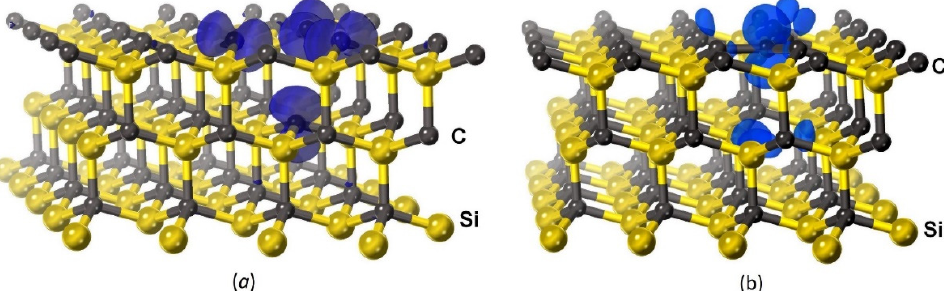
Figure 7. Difference in the density of electrons with spin “up” and “down”, corresponding to the value of 0.05 e / 3 for the systems with V Si ( a ) and C 4 V ( b ). Cases ( a , b ) are specific to SiC grown on Si of p- and n-type, respectively.